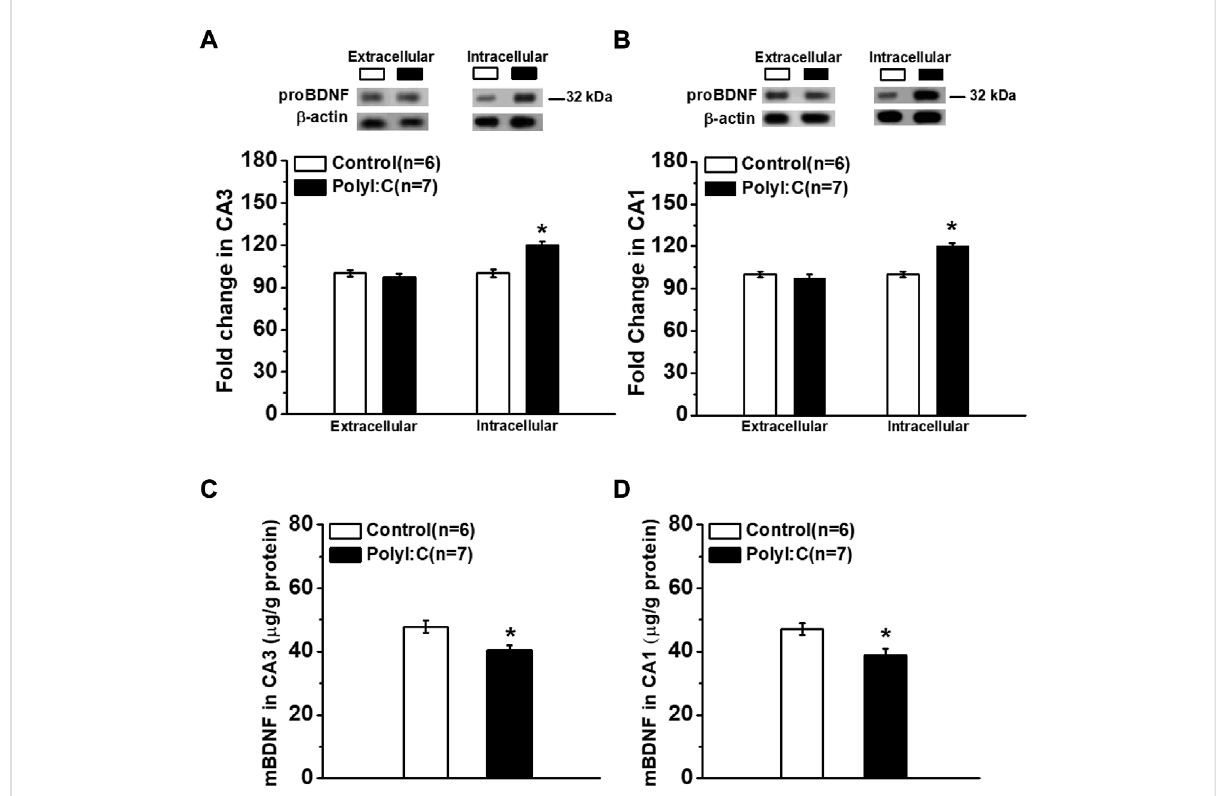
Theexpression ofproBDNFinhippocampal CA3and CA1regions. WesternblotanalysisshowstheproBDNFexpressioninCA3. (A) andCA1. (B) regions are abnormal increased. ELISA analysis of mBDNF concentration in CA3 (C) and CA1 (D) regions. Data are presented as mean ± SEM. * p < 0.05. Control: n = 6; PolyI:C: n = 7.